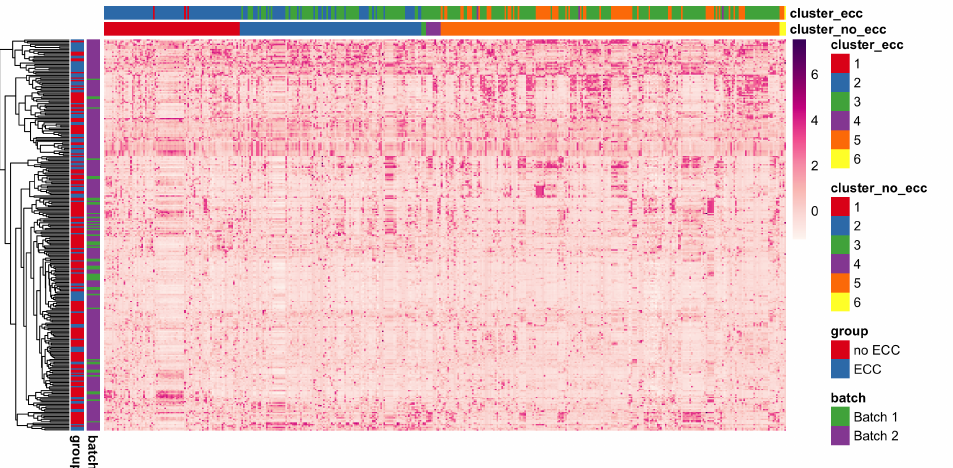
Figure 9. Heatmap of species-wise standardized counts illustrating species module identification results (species are columns and modules are presented with different colors) using BZINB-based species spectral clustering. Each column represents a single species. Columns are ordered by the clusters predicted from the affinity matrix based on the BZINB correlations between species in the healthy (non-ECC) group. The columns are annotated to show and compare the estimated clusters within health (non-ECC) and disease (ECC) groups. Each row represents a participant, and the rows are ordered based on hierarchical clustering. Rows (n = 289) are annotated to denote healthy/disease and batch groups. Standardized counts were calculated separately for each species by first suppressing outliers (defined as greater than 3 × IQR from the first or third quartile), then centering around the median and dividing by the standard